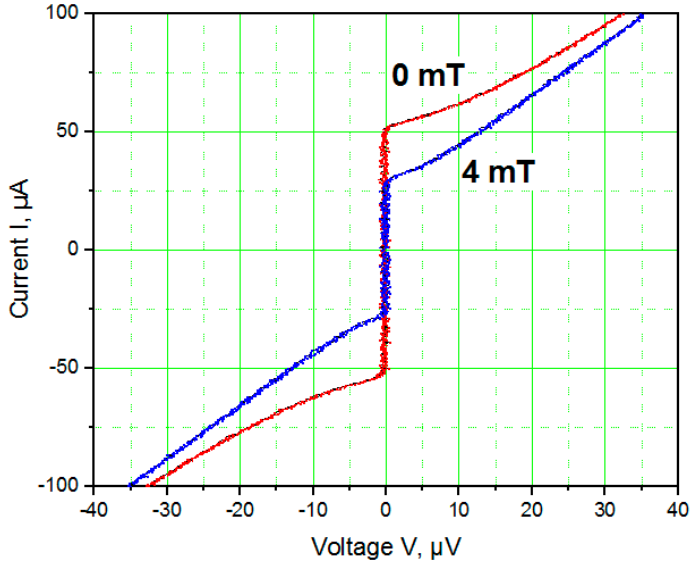
Figure 8. I ( V ) characteristics of a TiN nanoSQUID measured in magnetic fields of 0 mT and 4 mT at 4.2 K.